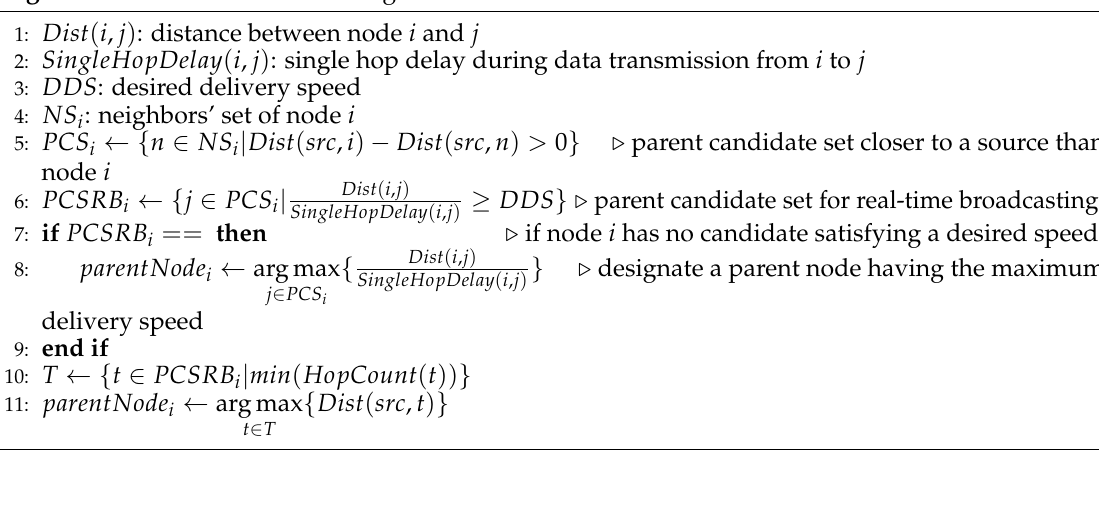
Algorithm 1 Real-time broadcasting tree construction